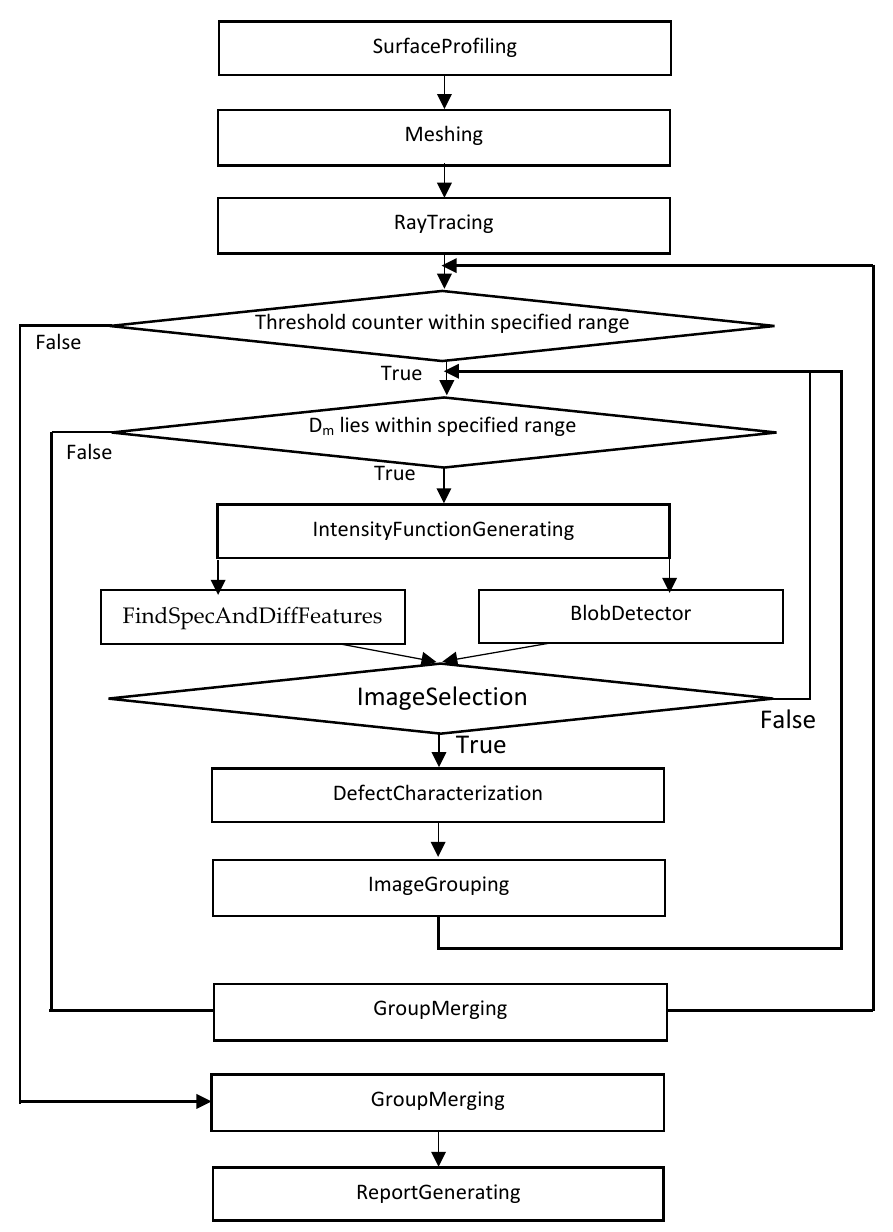
Figure 3. A flowchart of